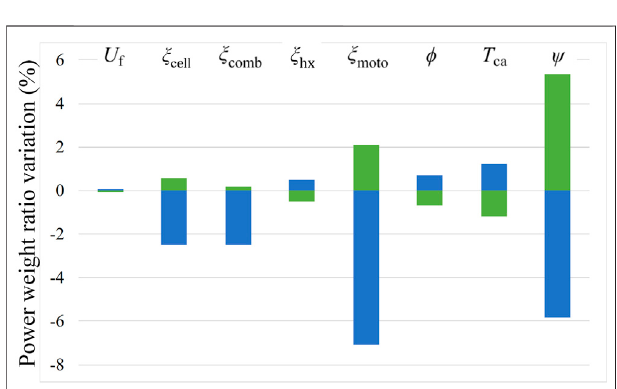
FIGURE 8 | Spider diagram of the sensitivity of speci fi c thrust of the HEFC engine vs. seven design parameters.